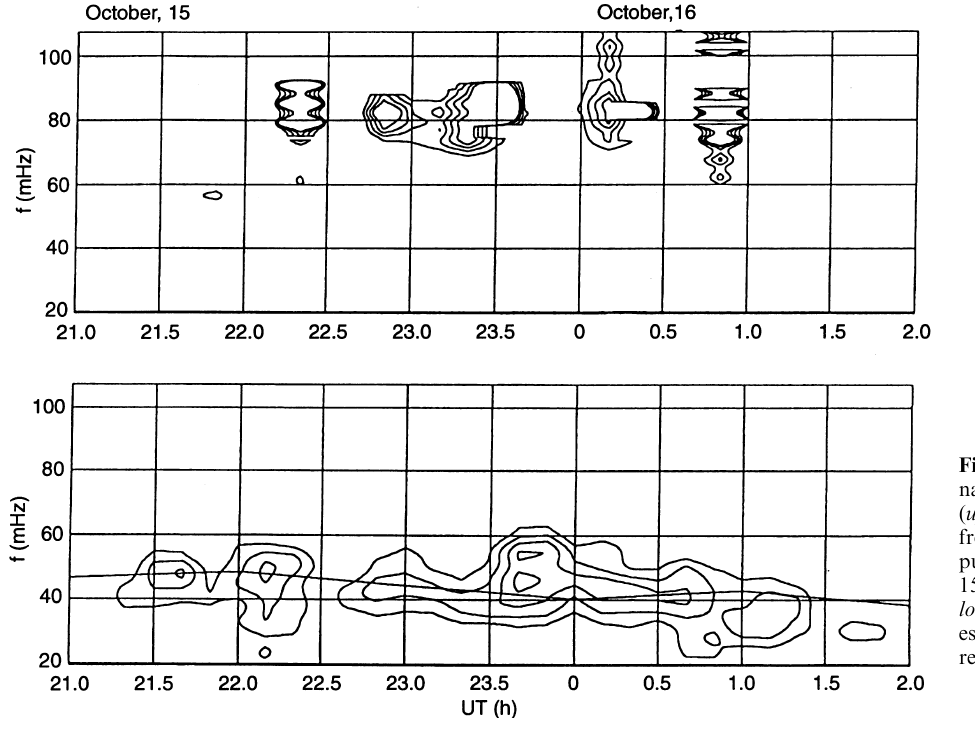
Fig. 13. Variations of the reso- nant frequency f R at L (cid:136) 1 : 6 ( upper ) and the expected source frequency f O ( bottom ) of Pc3 pulsations recorded on October 15–16, 1992. The solid line in the lower panel shows the frequency estimated with the f (cid:136) 6 : 3